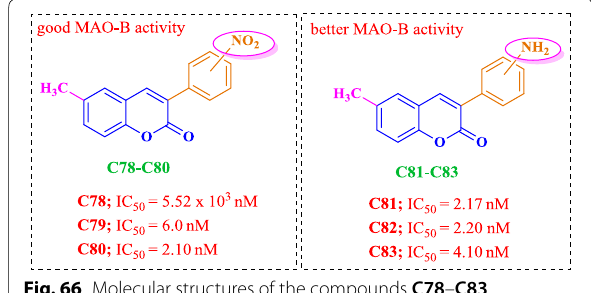
Fig. 65 Molecular structures of the compounds C74 – C77